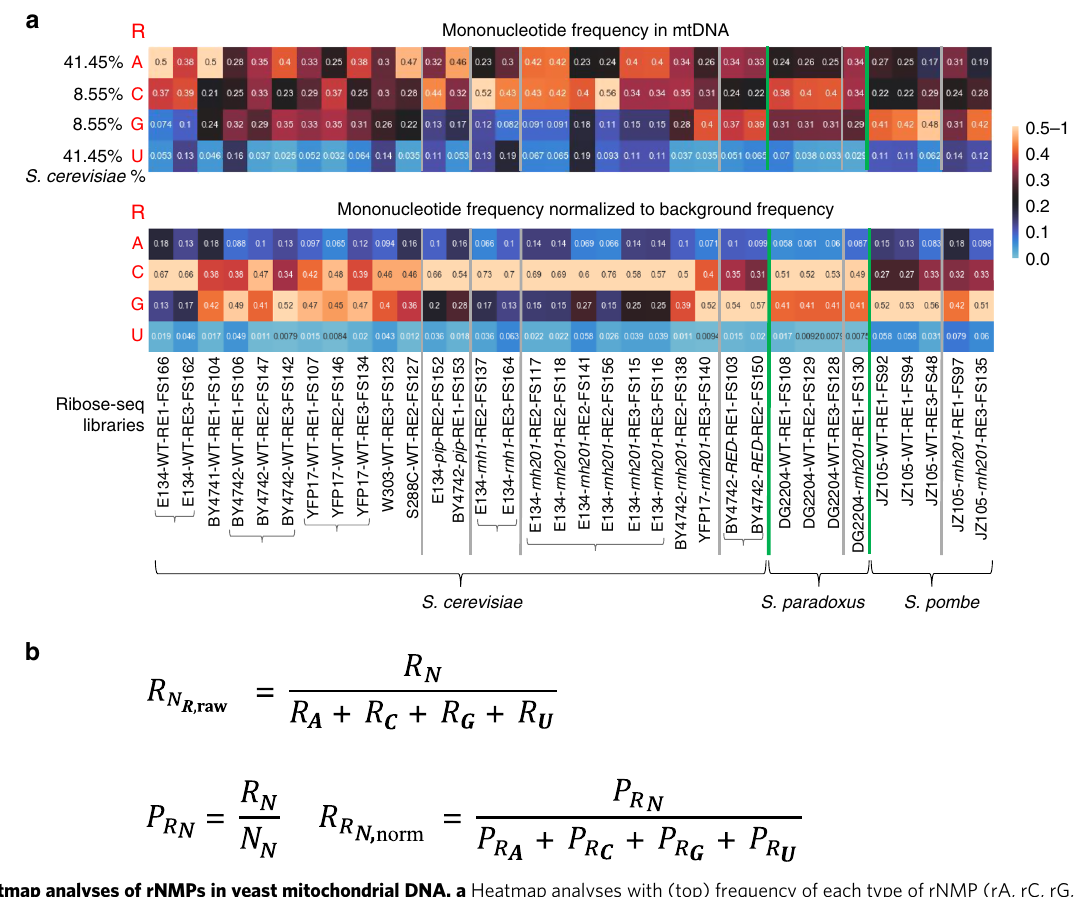
Fig. 2 Heatmap analyses of rNMPs in yeast mitochondrial DNA. a Heatmap analyses with (top) frequency of each type of rNMP (rA, rC, rG, and rU), and (bottom) frequency of each type of rNMP normalized to the nucleotide frequencies of the corresponding reference genome for all the mitochondrial ribose- seq libraries of this study. The corresponding formulas used are shown in b and explained in Methods. Each column of the heatmap shows results of a speci fi c ribose-seq library. Each library name is indicated underneath each column of the heatmap with its corresponding strain name, genotype, and restriction enzyme (RE) set used. The yeast species of the ribose-seq libraries are also indicated. S. cerevisiae libraries derived from the same strains are grouped together by curly brackets. Thick, vertical, green lines separate data from the different yeast species. Vertical gray lines separate data obtained from different RNase H genotypes within each species. Each row shows results obtained for an rNMP (R in red) of base A, C, G, or U for each library. The actual percentages of A, C, G, and T bases present in mtDNA of S. cerevisiae are shown to the left of the top heatmap and are indicated in Supplementary Data 2A. The corresponding base percentages for mtDNA of S. paradoxus and S. pombe are indicated in Supplementary Data 2B and 2C, respectively. The bar to the right shows how different frequency values are represented as different colors: black for 0.25; black to yellow for 0.25 to 0.5 – 1, and black to light blue for 0.25 to 0. b Formulas used to calculate the frequency and the normalized frequency values of the mitochondrial heatmaps in a , see explanations in